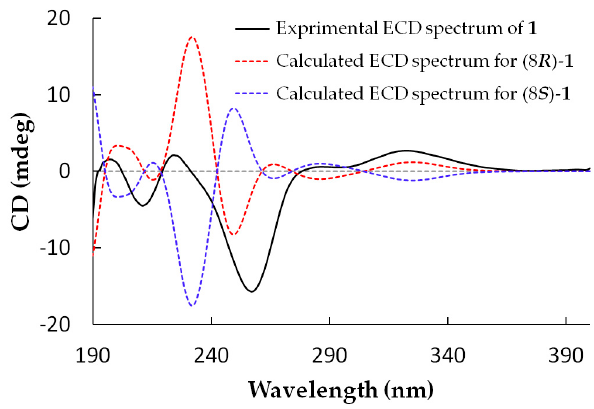
Figure 3. Experimental and theoretical ECD spectra for 1 .